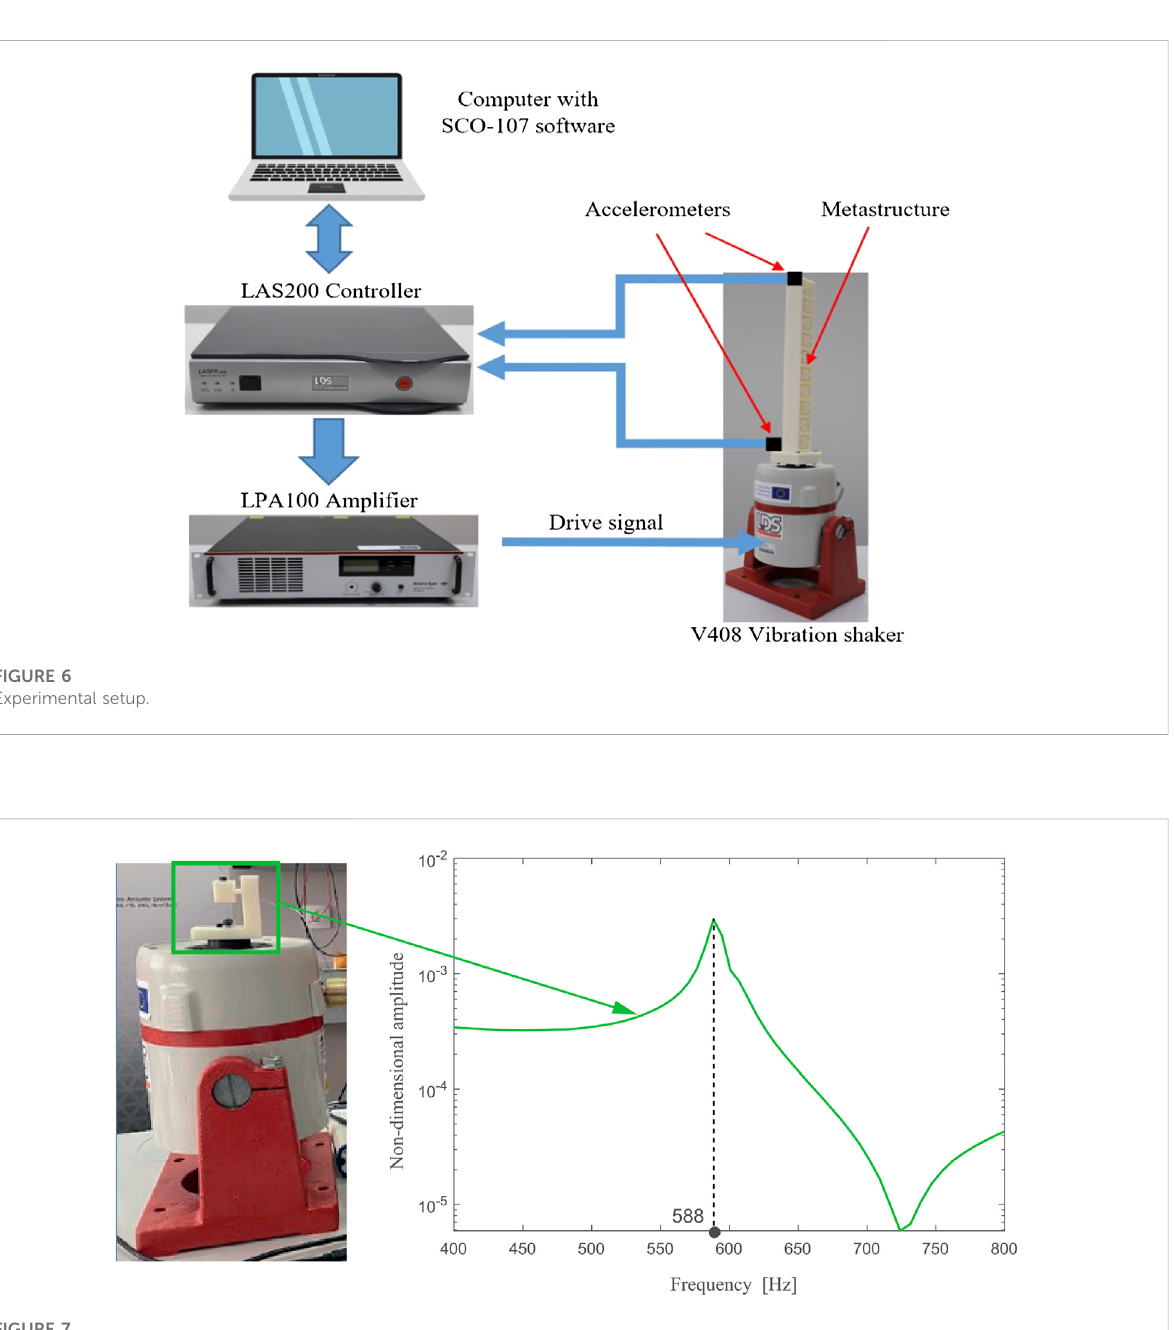
FIGURE 7 Experimentally obtained amplitude-frequency characteristics of one internal